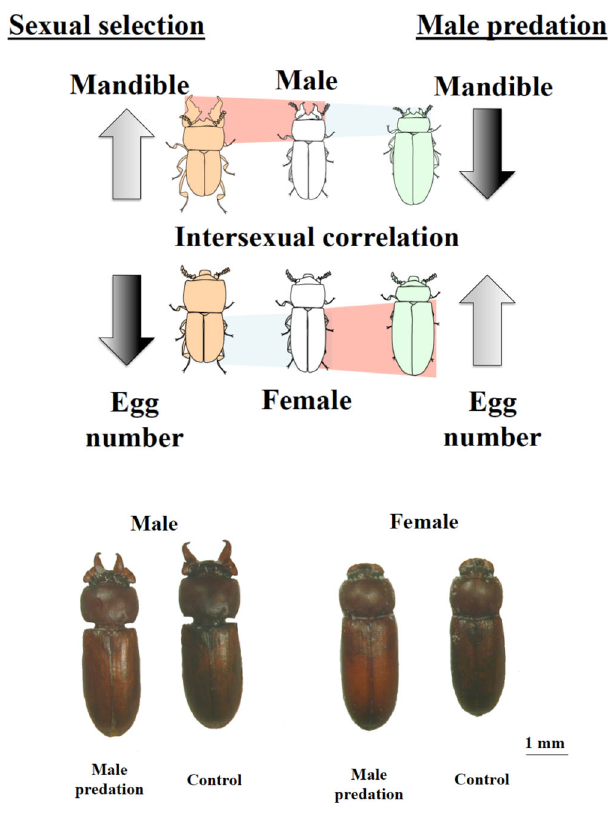
Fig. 4 The phenotypes after experimental evolution. The upper panel is a diagrammatic representation of the male and female phenotypes resulting from male-limited predation in comparison to those resulting from sexual selection on males. Sexual selection (left images) results in enlarged male mandibles, which require a masculinized head and prothorax to operate effectively. This fore-body masculinization results in a smaller male abdomen and because of intersexual correlations for abdomen size, a smaller female abdomen and capacity for fewer eggs, even though females never develop mandibles. Male-limited predation selects against the masculinized phenotype, ultimately resulting in larger male and female abdomens, and hence more eggs and higher fi tness females (images on the right). The lower plate shows beetles from the male predation and control treatments and reveals the impact of evolving with male predation described above — both males and female evolve more feminized phenotypes (smaller mandibles for males and larger abdomen for both) compared to the controls (NB controls and female-predation have similar phenotypes (Figs. 1 and 2) hence we show only controls for clarity). Images were created by us.